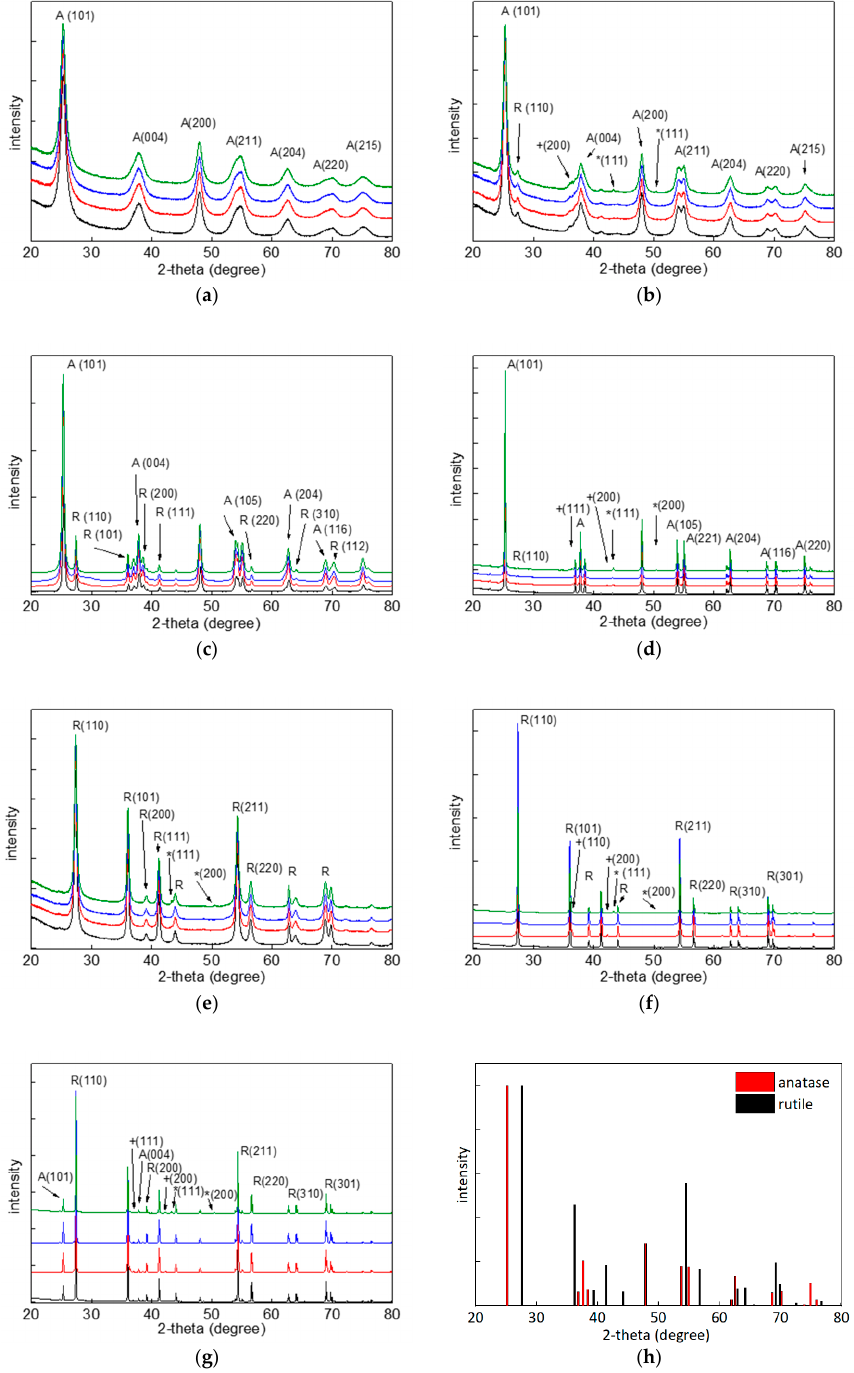
Figure 3. X-ray di ff raction (XRD) patterns of: (a-g) bare and copper-modified TiO 2 : ( a ) ST-01, ( b ) FP6, ( c ) P25, ( d ) ST-41, ( e ) TIO-6, ( f ) ST-G1 and ( g ) TIO-5 (black: bare, red: m-1h, blue: w-1h, green: m-5h); A and R indicate anatase and rutile, respectively; Symbols (* and + ) indicate Cu and Cu 2 O, respectively; ( h ) standard XRD patterns of anatase (red) and rutile